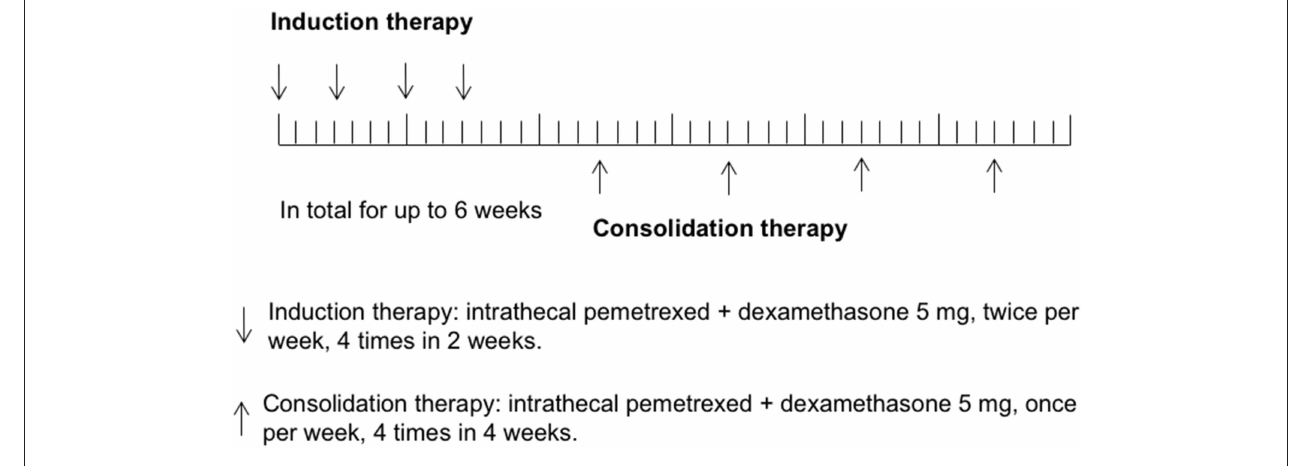
FIGURE 1 | Study schema.